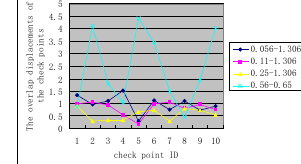
Figure 8: registration results’ position deviation of check points